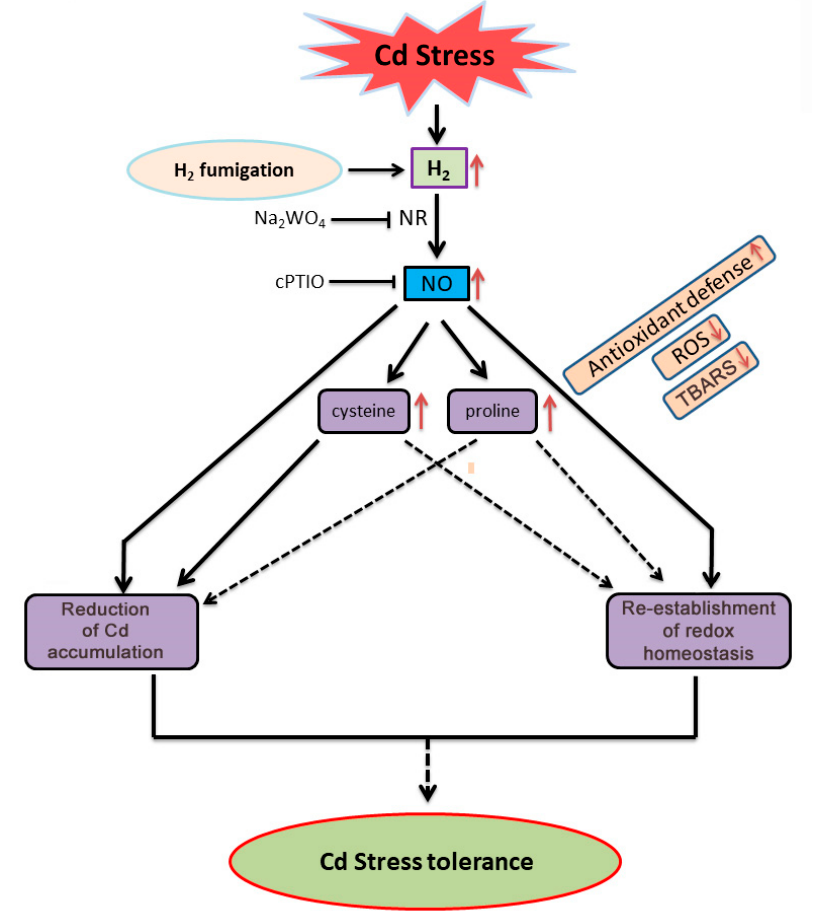
Figure 10. A model illustrating the participation of NO and the possible involvement of cysteine and proline in the H 2 -induced alleviation of Cd stress on G. lucidum. In this model, the solid arrows and T bars indicate data supported by our own experiments. The dashed arrows and T bars indicate hypothetical steps or findings from previous studies. T bar represents the inhibitory or scavenging effect.